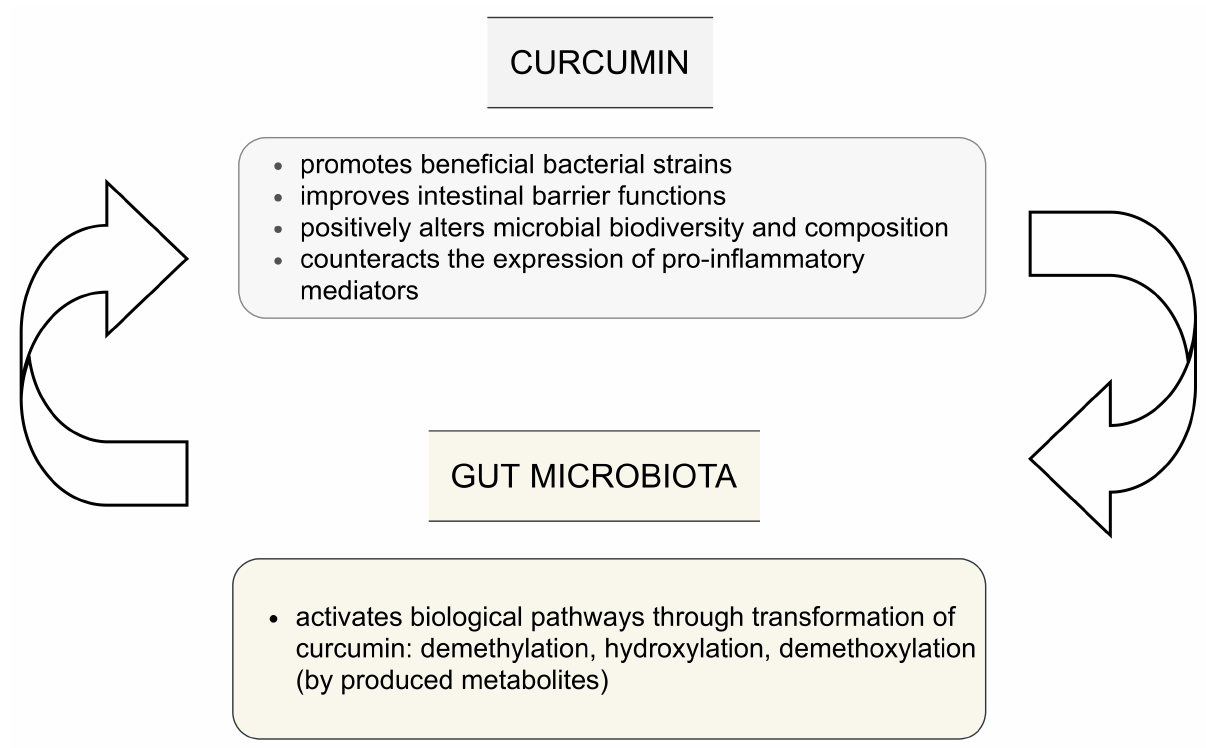
Figure 2. Interplay between curcumin and gut microbiota; based on